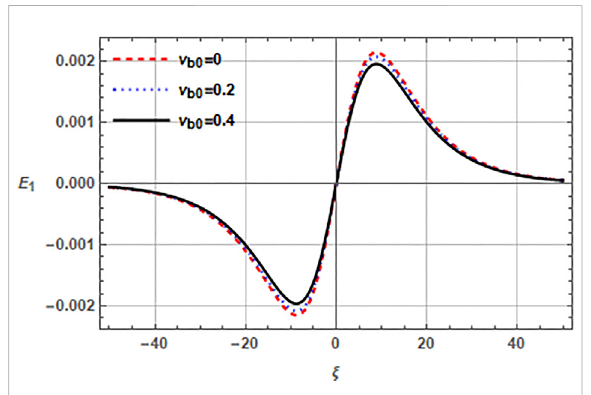
FIGURE 2 Variation of normalized electric fi eld E 1 ( ξ , τ ) of EASW against thenormalizedspatialscale ξ byvaryingthespectralindices r and q andcomparison withMaxwelliandistribution.Here, n c 0 = 0.5 cm − 3 , n h cm − 3 , n b cm − 3 , σ c = 0.001, σ b = 0.01, v b 0 = 2 0 = 1 τ = 0.